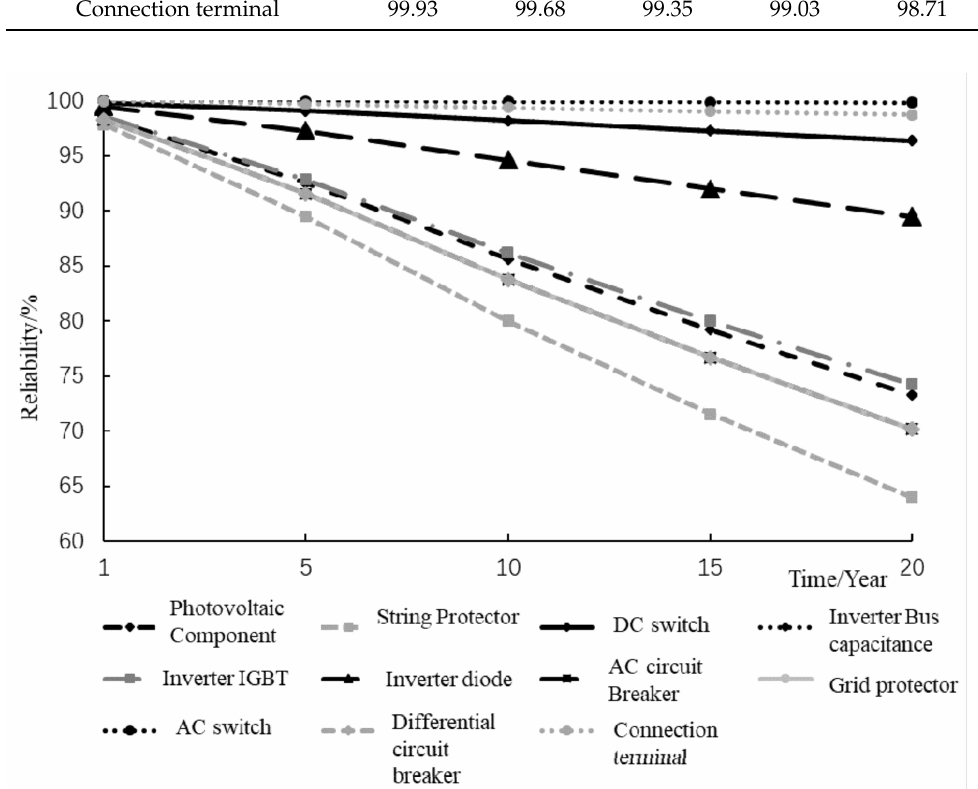
Figure 10. Reliability of components in a 10 KW grid-connected PV power station after 20 years of